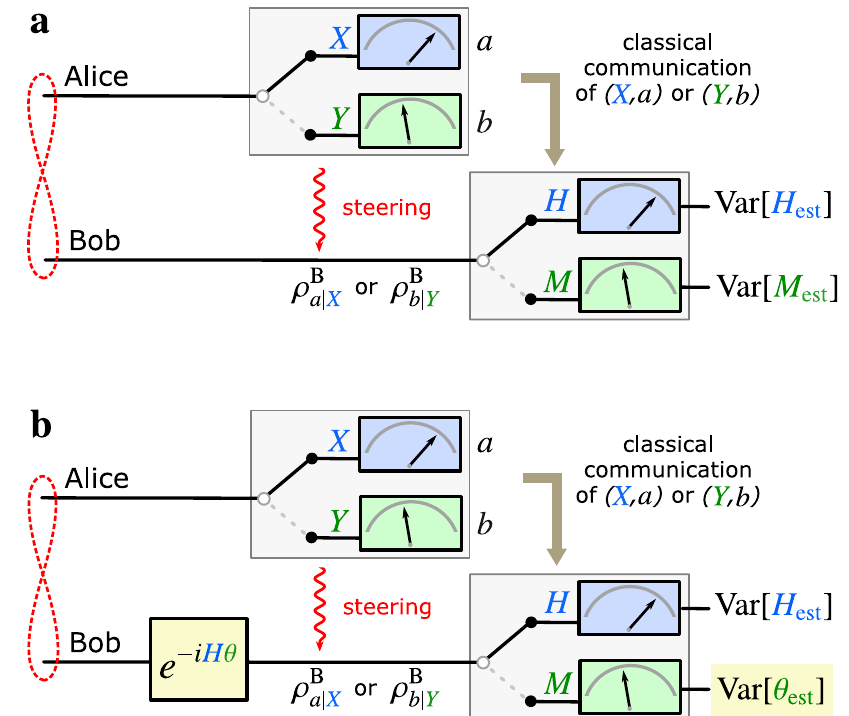
Fig. 1 Formulation of the EPR paradox as a metrological task. a In the standard EPR scenario, Alice ’ s measurement setting X ( Y ), and result a ( b ), leave Bob in the conditional quantum states ρ B a j X ( ρ B b j Y ). Knowing Alice ’ s setting and result allows Bob to choose what measurement to perform on his state, and to make a prediction for the result. In an ideal scenario with strong quantum correlations, Alice ’ s measurement of X ( Y ) steers Bob into an eigenstate of his observable H ( M ), allowing him to predict the result with certainty. When H and M do not commute, this seems to contradict the complementarity principle. In practice, an EPR paradox is revealed whenever Bob ’ s predictions are precise enough to observe an apparent violation of Heisenberg ’ s uncertainty relation, see Eq. (1). b In our formulation of the EPR paradox as a metrological task, a local phase shift θ is generated by H on Bob ’ s state. Then, depending on Alice ’ s measurement setting and result, he decides whether to predict and measure H (as before), or to estimate θ from the measurement M . Here, Bob can choose the observable M as a function of Alice ’ s measurement result. The complementarity between θ and its generator H seems to be contradicted if the lower bound on their estimation errors, Eq. (3), is violated. This gives a metrological criterion for observing the EPR paradox. Since the metrological complementarity is sharper than the uncertainty-based notion, this approach leads to a tighter criterion to detect steering. Both results coincide in the special case when Bob estimates θ only from the observable M